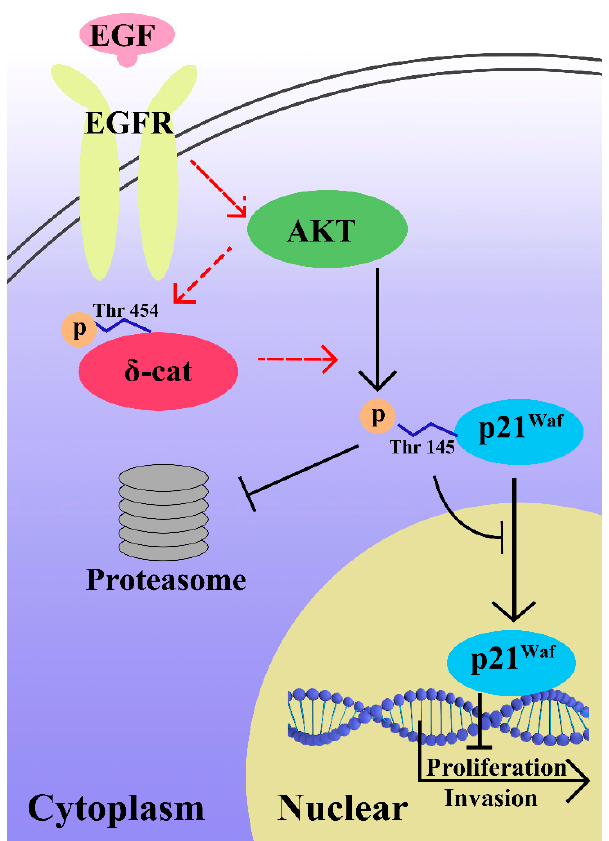
Figure 6. Schematic model showing the role of δ -catenin in EGF/AKT/p21 signaling in prostate cancer.